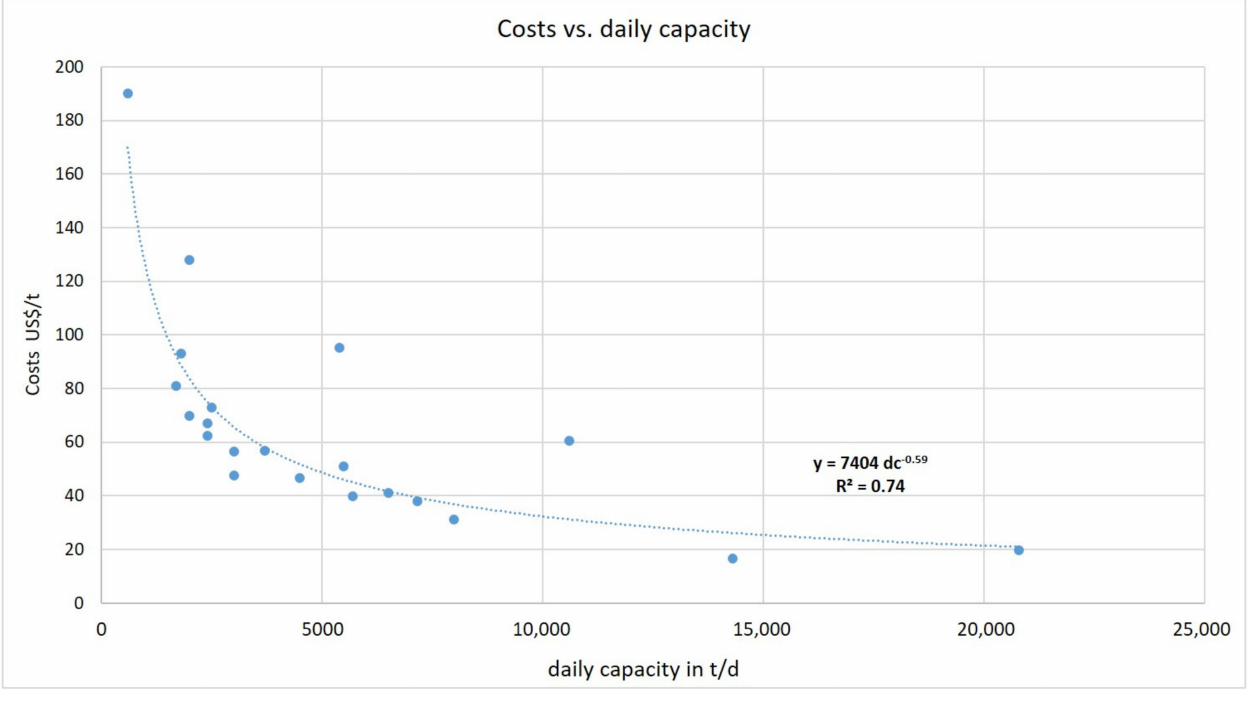
Figure 2. Operating costs as a function of daily capacity (dc) for underground lead–zinc mines (data source: [20]), [18] (with permission of Bolet í n Geol ó gico y Minero).